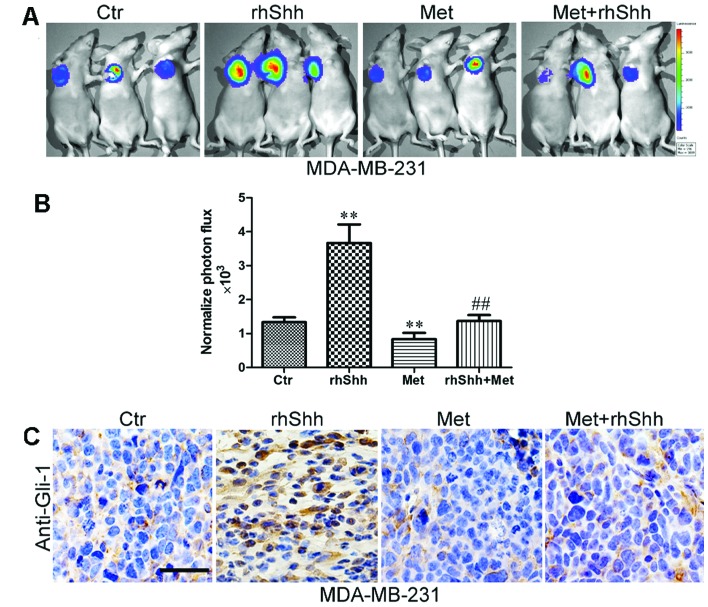
Metformin inhibits recombinant human Sonic hedgehog (rhShh)-induced tumor growth in the in vivo model of breast cancer. (A) Representative bioluminesence images of the control and the treatment groups: control (ctr; untreated), rhShh (intratumoral injections of rhShh, 1 mg/kg body weight), Met (oral gavage of metformin, 100 mg/kg body weight), Met + rhShh (a combination of both drugs). (B) Chart representing the average photon counts from the control and the treatment groups. The bars indicate the means ± SD of triplicate samples, **P<0.01 vs. the Ctr group, ##P<0.01 vs. the rhShh group. (C) The expression levels of Gli-1 in the tumors from the xenograft model were measured by immunohistochemistry. Gli-1 immunostaining was regarded as positive with brown granules exhibited in the cytoplasm of a cell. Final magnification, ×40. Scale bar, 50 µm.